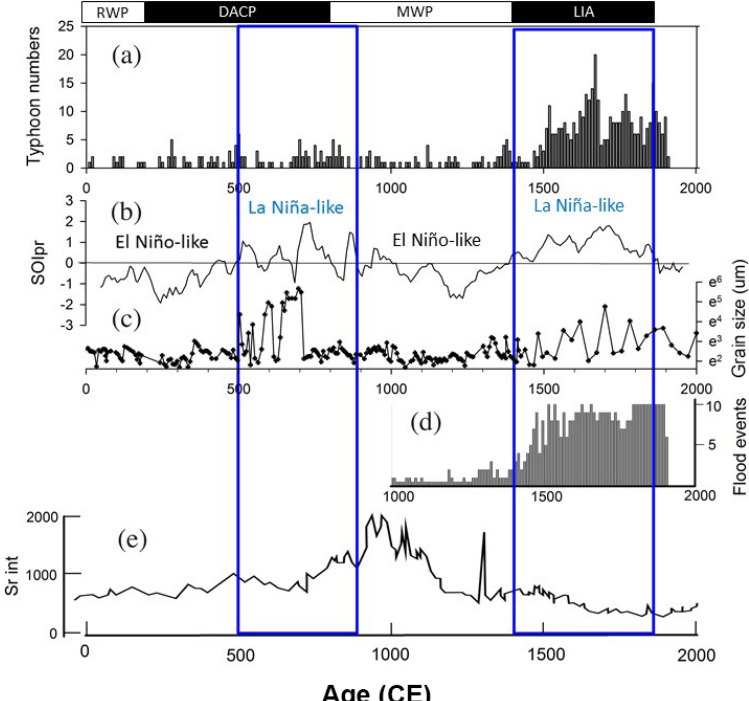
Figure 7. Correlations between typhoon events and ENSO. (a) Number of typhoons recorded in Chinese historical documents for the last 2000 years. (b) SOI pr (Southern Oscillation Index from precipitation proxies; Yan et al., 2011). (c) The change in particle sizes from lake sediments from Yilan, Taiwan, indicating the change in magnitude of typhoon rainfall (Chen et al., 2012). (d) Number of flooding events recorded in Chinese historical documents (Chu et al., 2002). (e) Variation in Sr in lagoon sediments from Kyushu, Japan, indicating influences from exceptionally strong typhoons (Woodruff et al., 2009). RWP: Roman Warm Period; DACP: Dark Ages Cold Period.